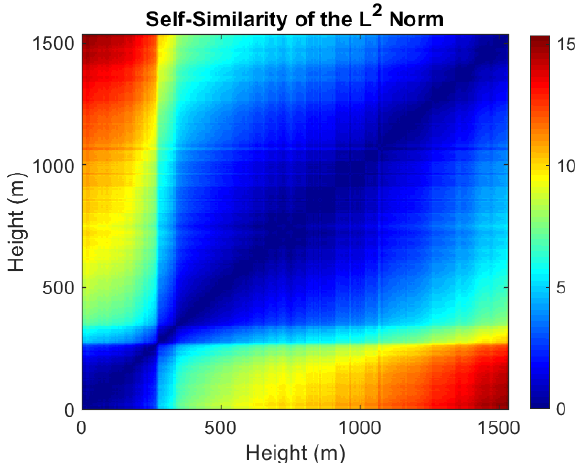
Figure D1. Plot of the self-similarity matrix of the L 2 -norm of at- mospheric values determined for the sampling flight on 12 June 2019. The first off diagonal represents the comparison of every value against every other value. This method was used to identify the PBL during all 2019 flight operations, later updated with the Calinski–Harabasz criterion